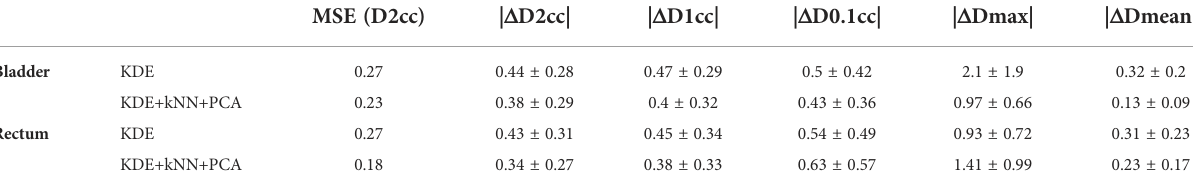
TABLE 4 Comparison of model performances using different methods.